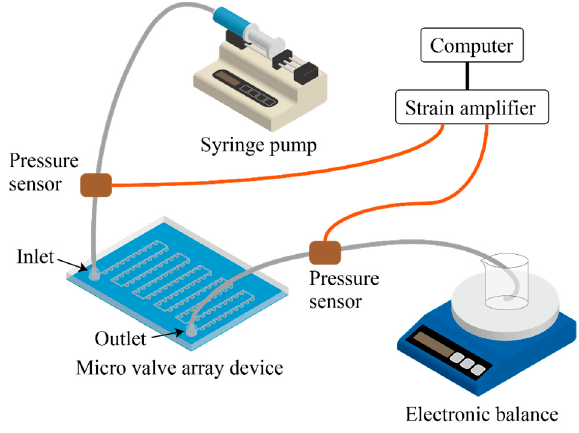
Figure 5. Setup for evaluation of valve properties.